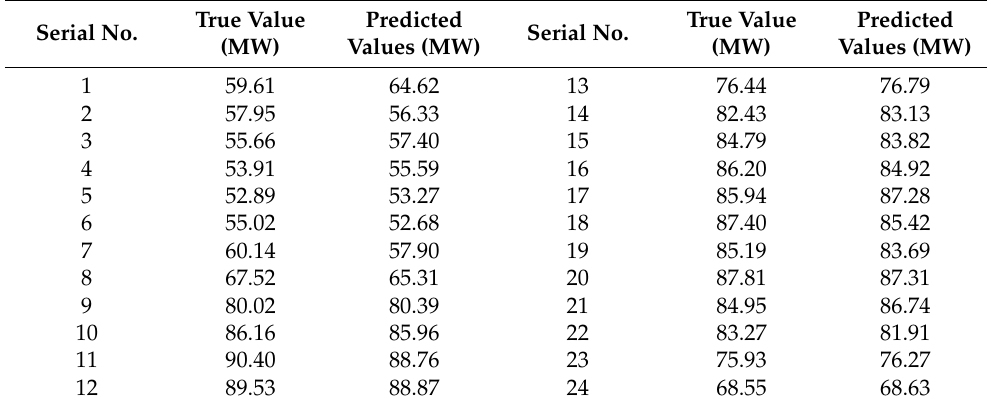
The comparison of the prediction curves generated, based on the SSA-LSTM prediction model, with the true value curves of the load data is shown in Figure